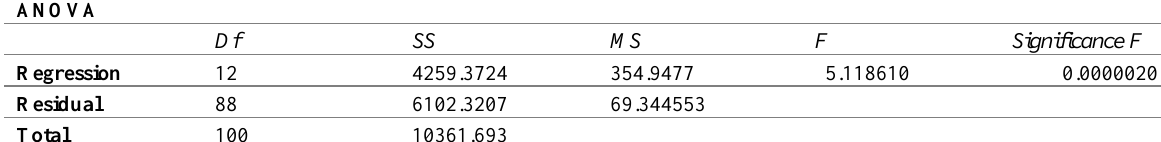
Table 8: ANOVA (Chittagong Division)